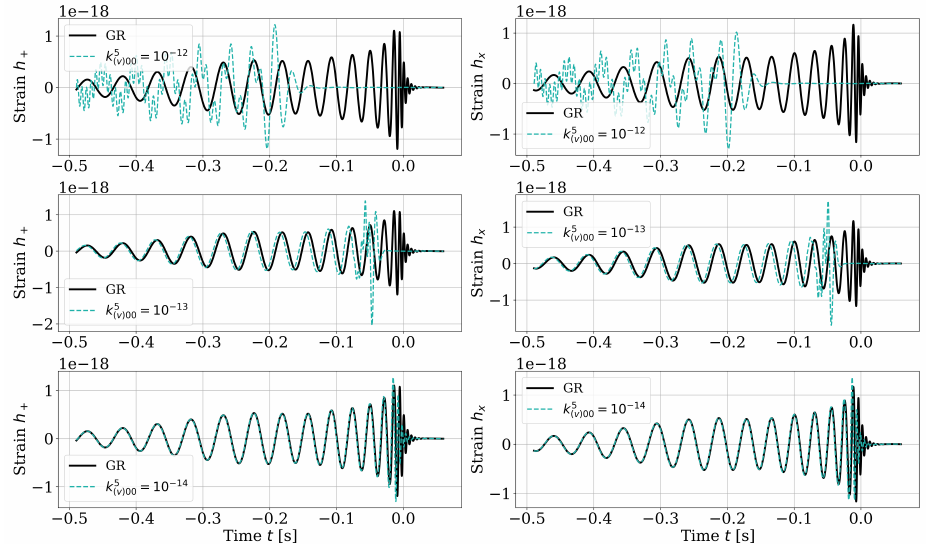
( 5 ) values are for a simulated coalescence of a ( V ) 00 ( 5 ) = 0, and Lorentz violation is the case where k ( 5 ) ( V ) 00